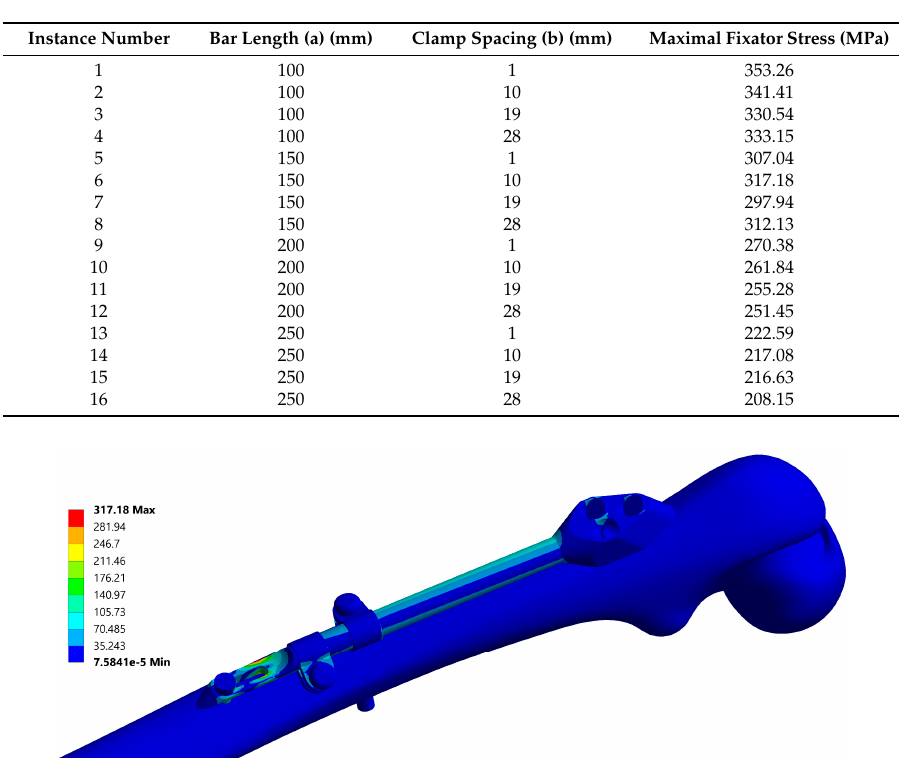
Table 2. CAD model instances, the corresponding values of the design parameters, and the calculated maximal fixator stress.